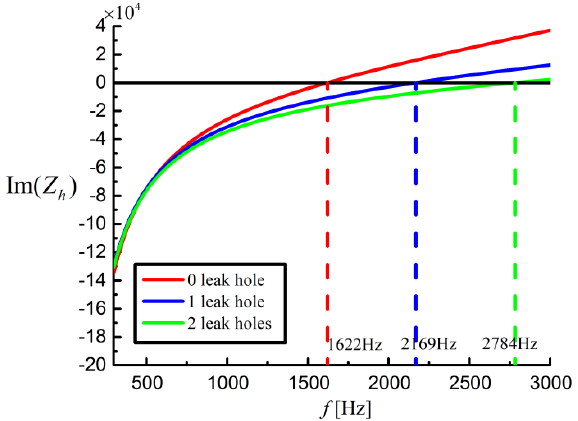
Figure 4. Effects of the number of leak holes on the transmission properties of the DHR device. The solid lines represent the theoretical results, while the circle lines represent the COMSOL predictions. ( a ) Amplitude vs. frequency; ( b ) Phase shift vs. frequency.